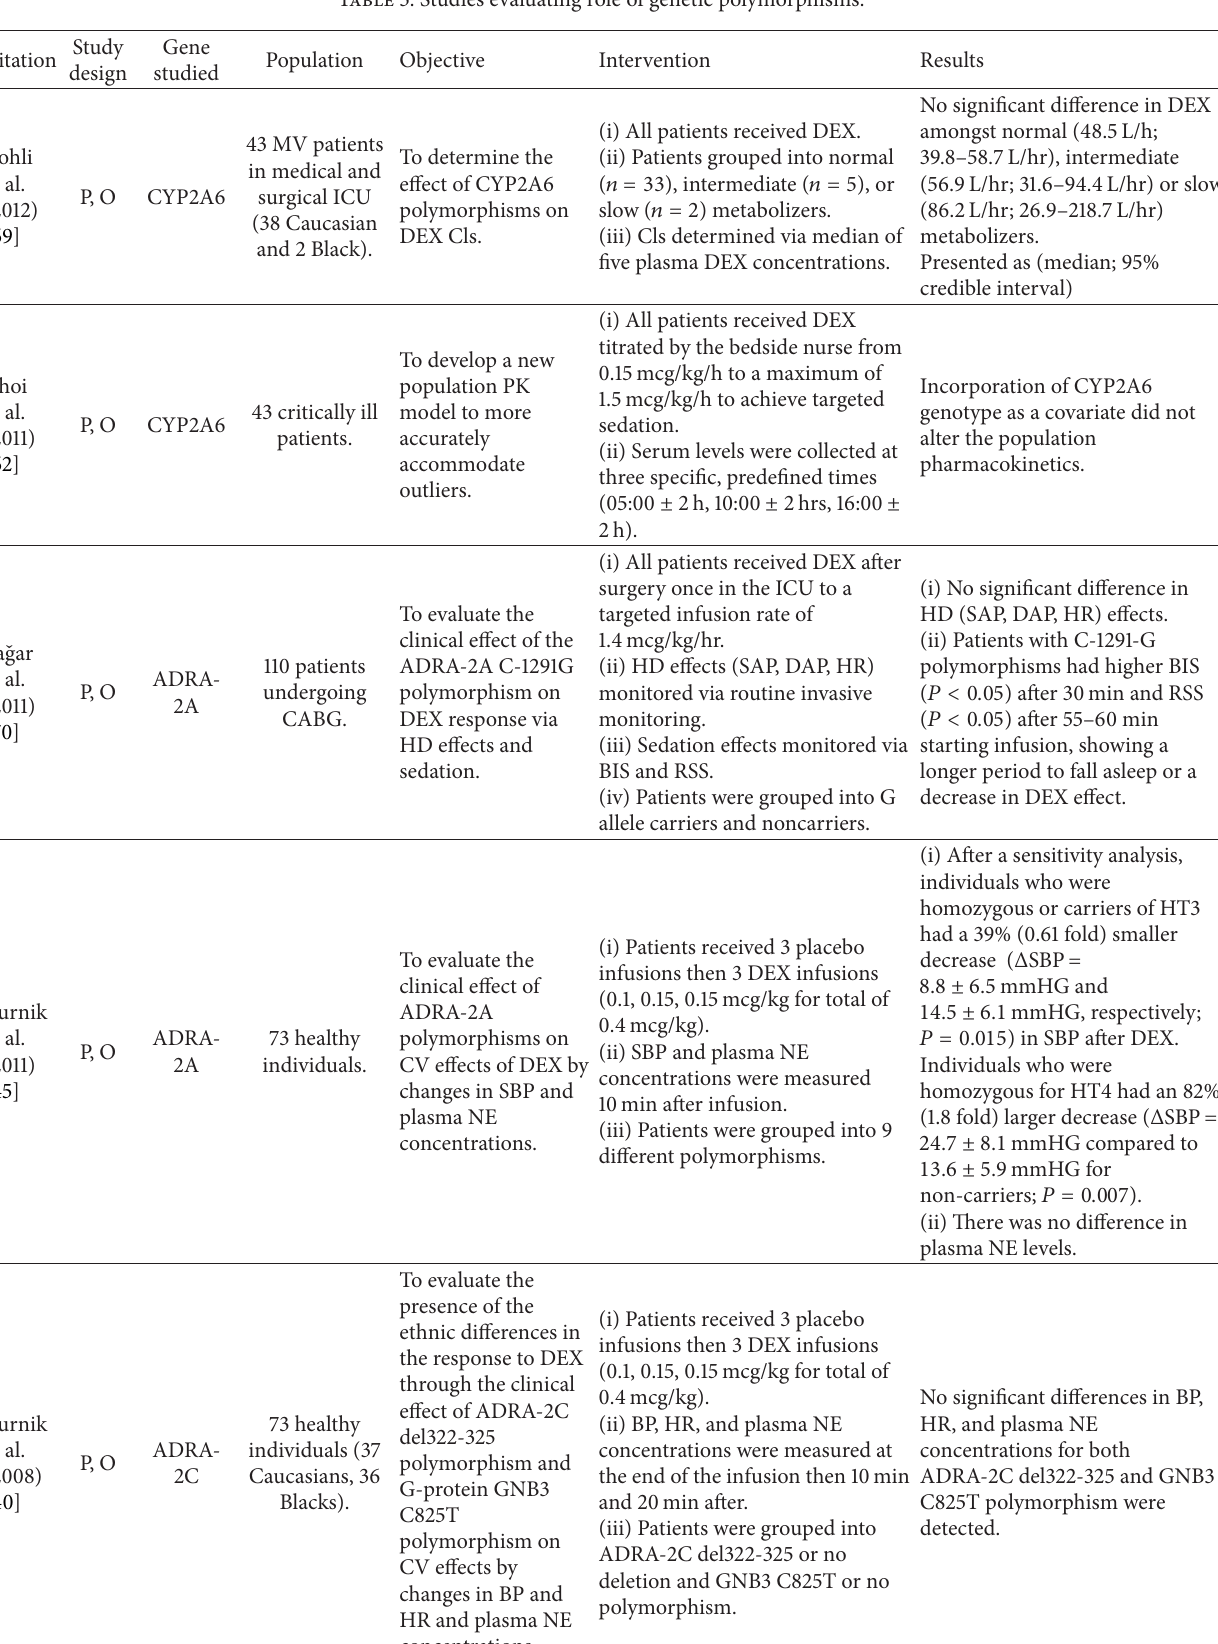
Table 3: Studies evaluating role of genetic